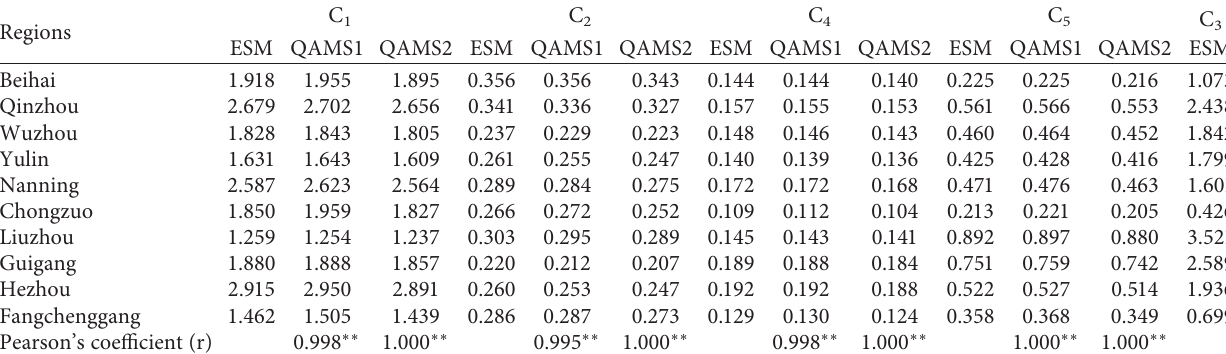
Table 6: Determination of 5 constituents by different quantitative methods (mg/g, n �